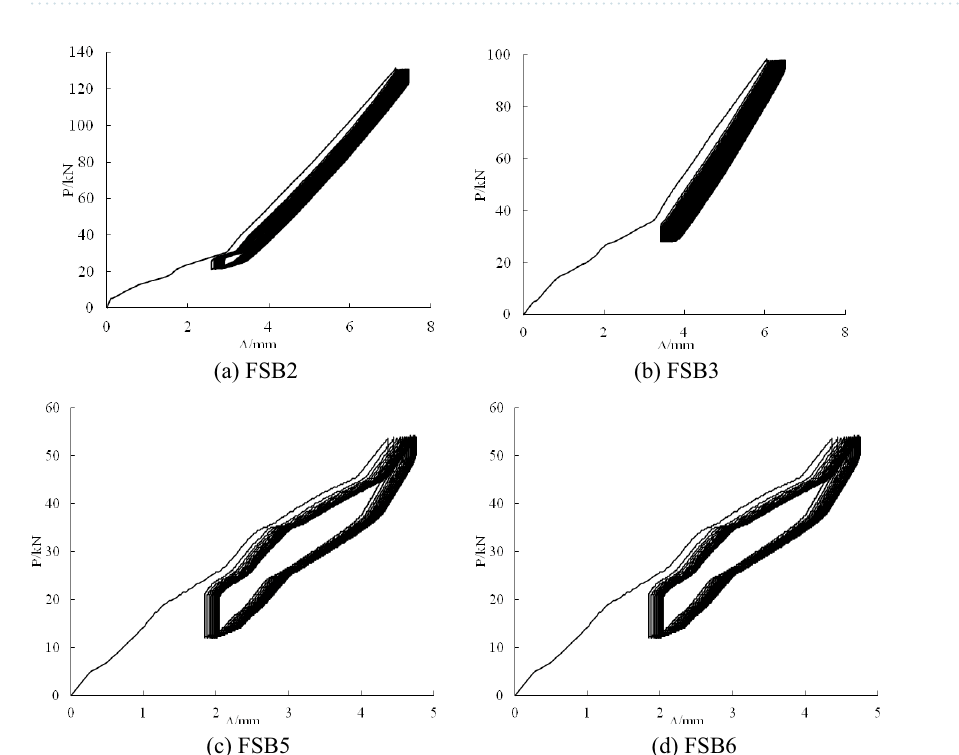
Figure 5. Load–deflection relationship of specimens with 100